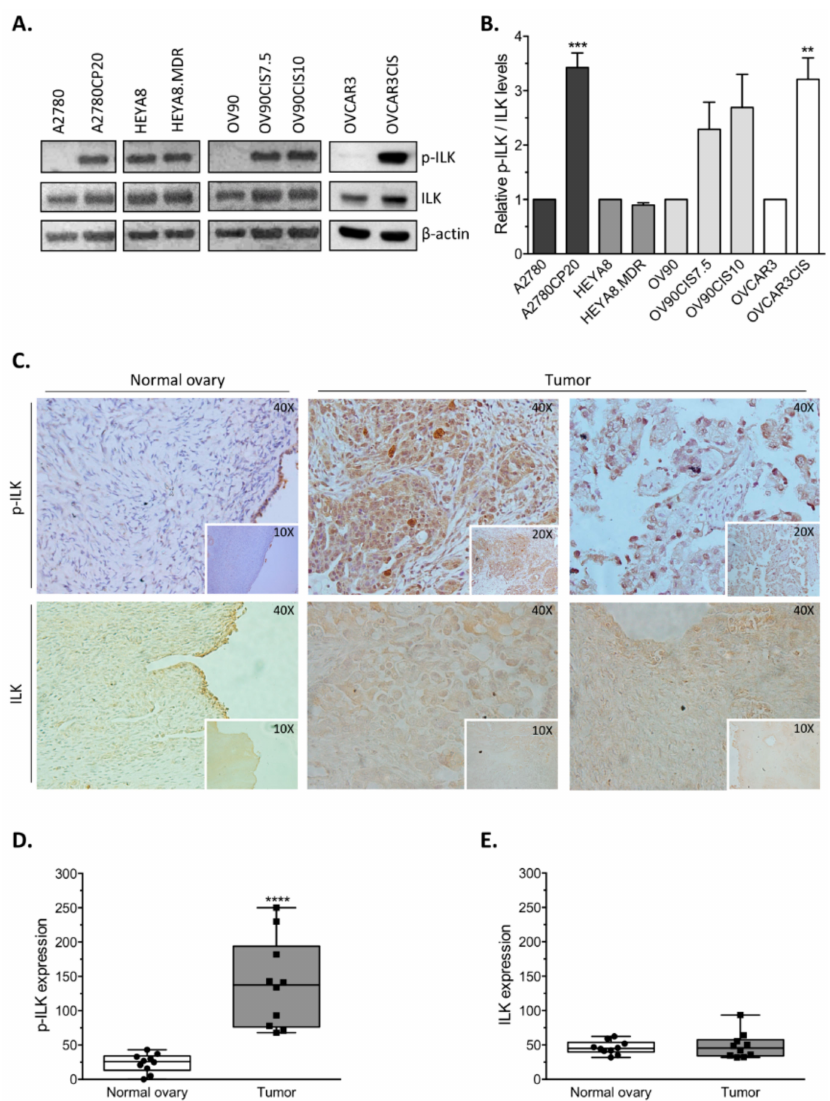
Figure 1. Expression of p-ILK and ILK in ovarian cancer cells and ovarian tumor samples. Western blot analysis and immunohistochemical (IHC) staining were performed. ( A ) Representative Western blots showing the phosphorylated form of ILK (p-ILK) and total ILK protein levels in a panel of ovarian cancer cell lines. ( B) Densitometric analysis of the band intensities shown in Figure 1A plotted as mean ± SEM (** p < 0.01 and *** p < 0.001). Phosphorylated ILK / total ILK (p-ILK / ILK) was calculated relative to parental cell lines for each group. ( C ) Representative IHC of p-ILK and ILK protein levels in normal ovary and tumor samples from ovarian cancer patients. ( D ) Expression of p-ILK and ( E ) ILK (positive staining) plotted as mean ± SEM (**** p <